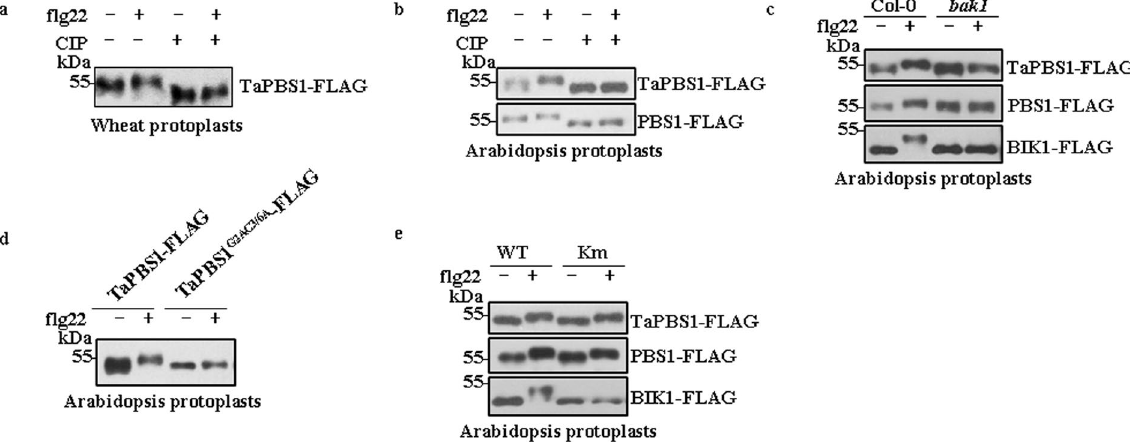
Figure 8. Flagellin induces TaPBS1 phosphorylation in vivo . ( a ) Flg22 induces a mobility shift of TaPBS1 expressed in wheat protoplasts. TaPBS1-FLAG was transfected in wheat protoplasts. Then the wheat protoplasts were incubated for 8 h and treated with 1 μ M flg22 for 10 min before harvesting. For CIP (calf intestinal alkaline phosphatase) treatment, 1 μ M CIP was applied in the reactions containing TaPBS1 proteins and incubated at 37 °C for 1 h. Proteins were separated with SDS-PAGE, and TaPBS1 was detected by Western blot analysis with an anti-FLAG antibody. ( b ) Flg22 induces a mobility shift of TaPBS1 expressed in Arabidopsis protoplasts. TaPBS1 or PBS1 was expressed in Arabidopsis protoplasts and was analyzed as above. ( c ) The flg22-induced TaPBS1 phosphorylation in Arabidopsis protoplasts depends on BAK1. Protoplasts were isolated from col-0 or bak1 mutant plants and were transfected with FLAG-tagged TaPBS1 , PBS1 , or BIK1 . ( d ) The flg22-induced TaPBS1 phosphorylation in Arabidopsis protoplasts depends on its PM localization. Arabidopsis protoplasts were transfected with TaPBS1 or TaPBS1 G2AC3 / 6A and treated with 1 μ M flg22 for 10 min before harvesting. The protein mobility shift was analyzed by Western blotting. ( e ) The kinase activity is not required for the flg22- induced TaPBS1/PBS1 phosphorylation. Arabidopsis protoplasts were transfected with TaPBS1 , TaPBS1Km , PBS1 , PBS1Km , BIK1 or BIK1Km and were treated with 1 μ M flg22 for 10 min before